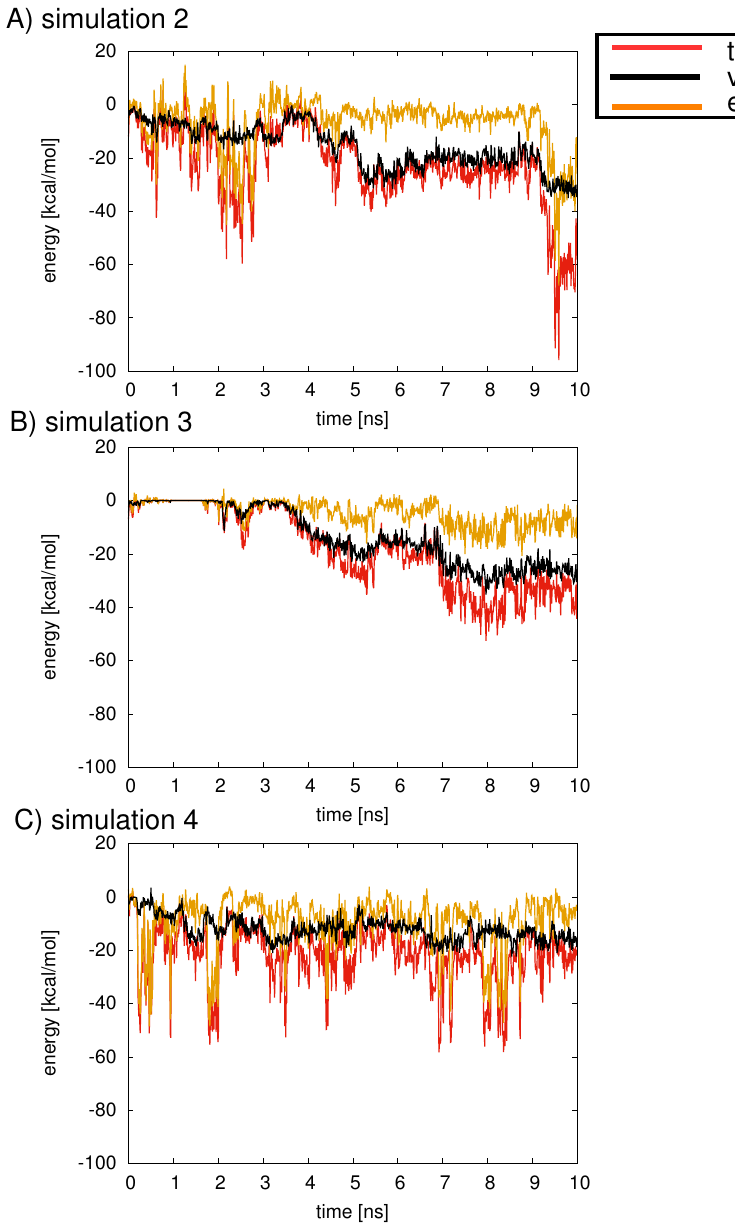
Figure 8. For each of the three independent simulations discussed in Figure 7, labeled simulation 2, 3, and 4 (shown in figures A, B, and C, respectively), the interaction energy [kcal/mol] (red) of SylA with all seven B 1 subunits was calculated over the length of the trajectory. A breakdown of the energies into van der Waals (black) and electrostatic (orange) components is